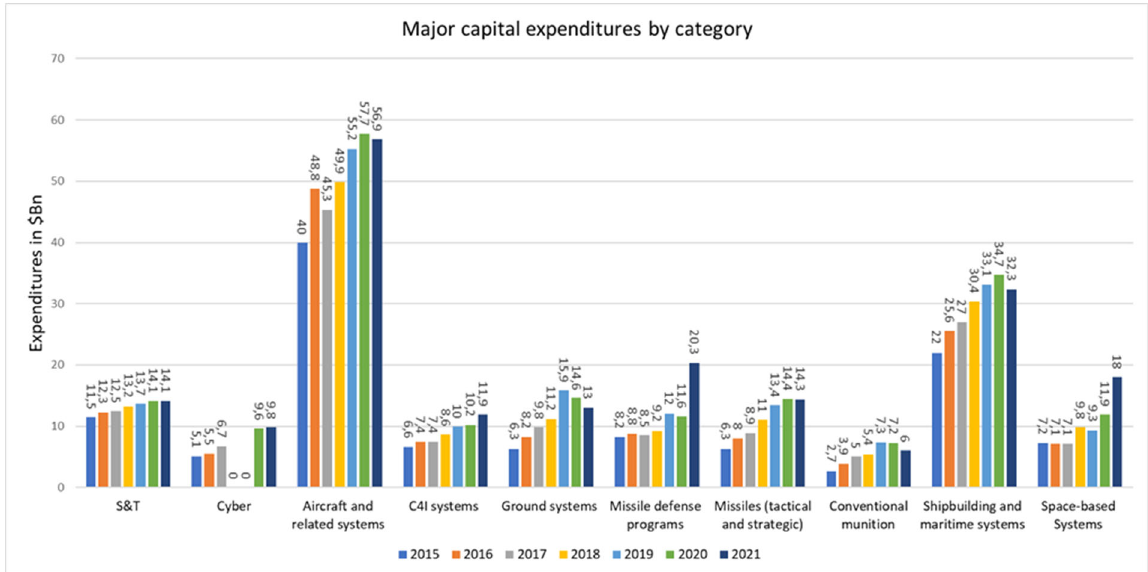
Figure 6. Major US capital expenditures by category over the period 2015–2021. Note: Values for expenditures within the cyber domain are not available for the fiscal years 2018 and 2019. Source: Own visualisation based on data from the U.S. DoD yearly budgetary request (2015–2021).